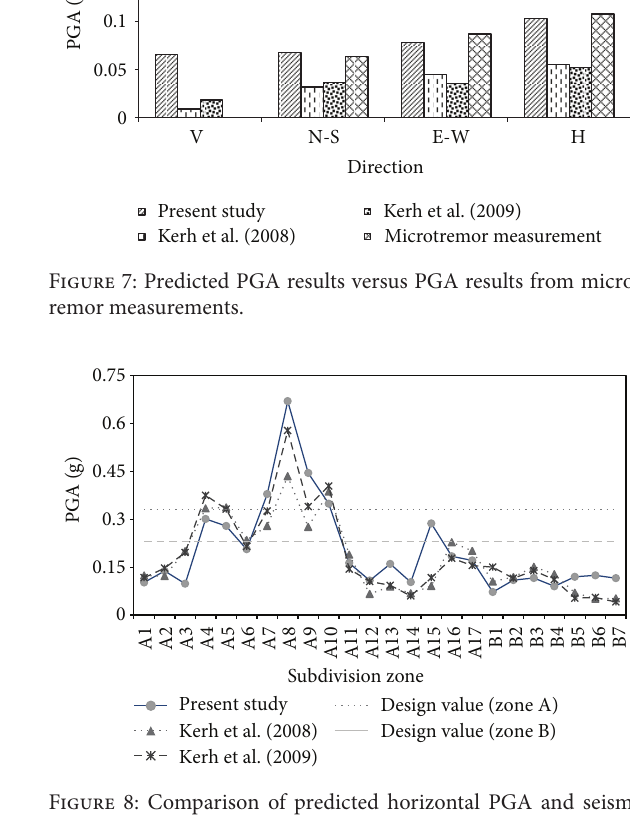
Figure 8: Comparison of predicted horizontal PGA and seismic design